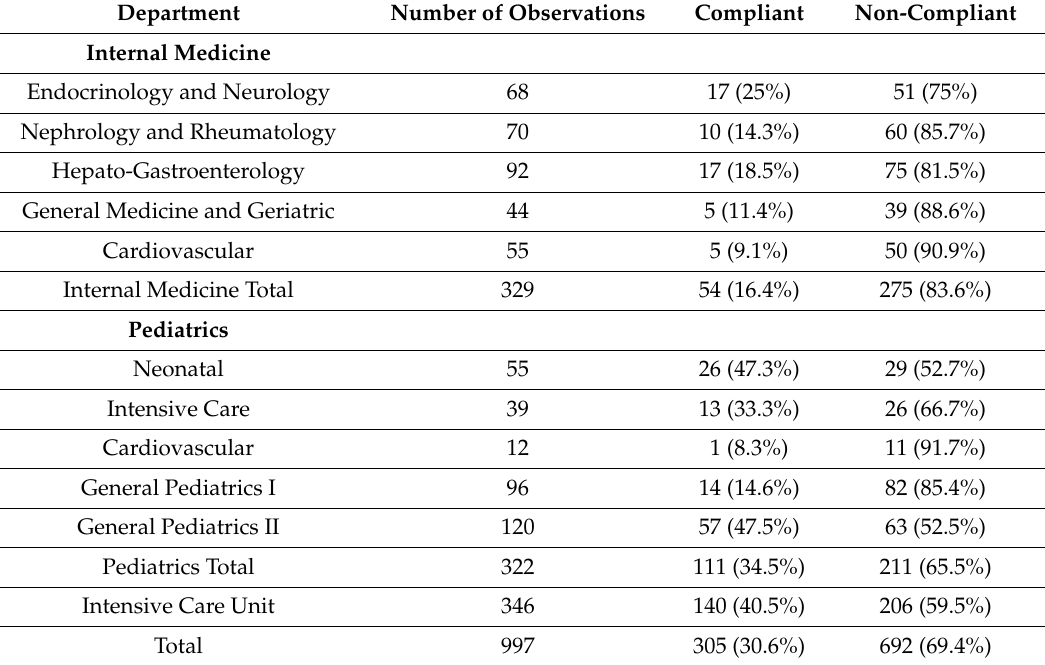
Table 4. Hand hygiene compliance of different departments from direct